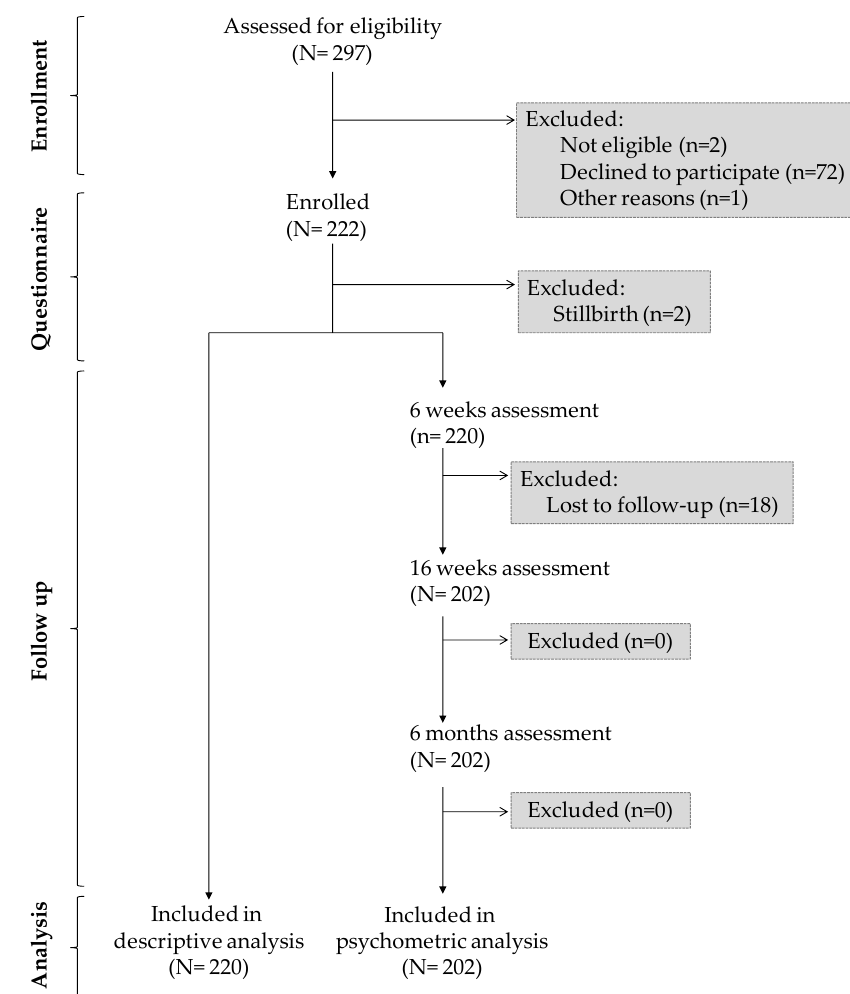
Scheme 1. Flow chart of study population selection. The grey boxes show the women excluded from the study.